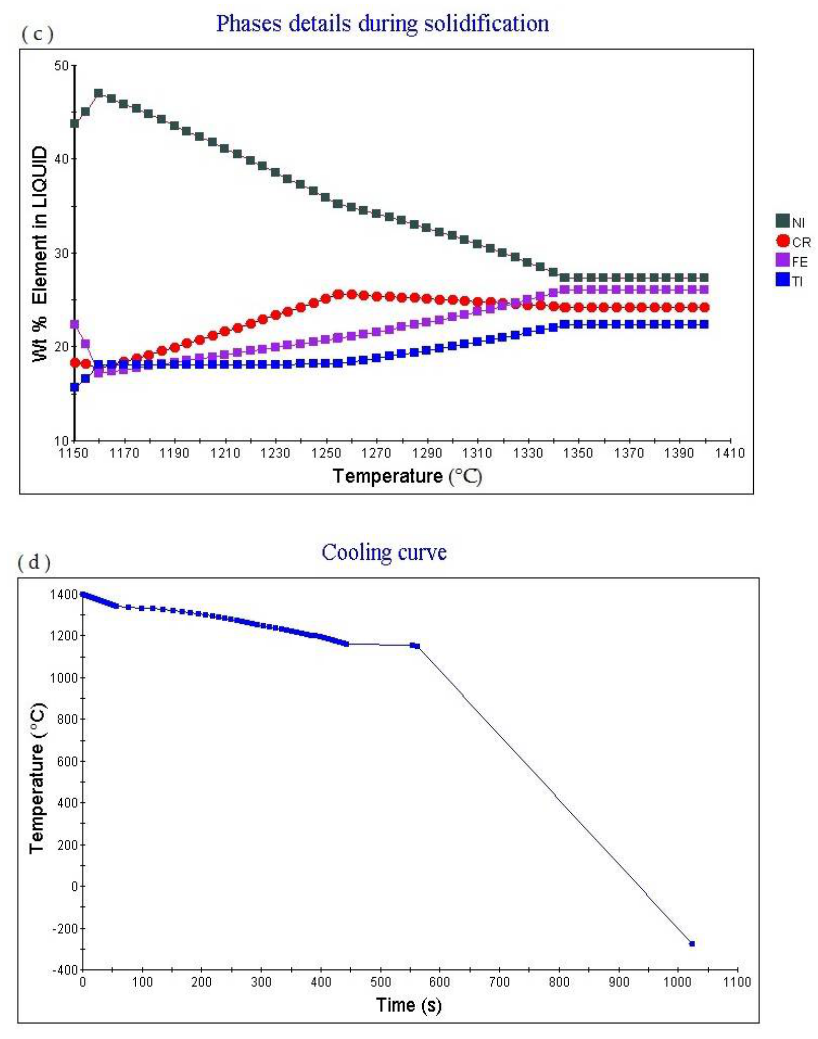
Figure 6. Solidification physical properties Physical properties for Fe 25 Cr 25 Ni 25 Ti 25 multi-principle element alloys. ( a ) General physical properties (fraction solid–temperature); ( b ) general physical properties (fraction liquid–temperature); ( c ) wt.% element in liquid–temperature; ( d ) cooling curve (temperature–time).